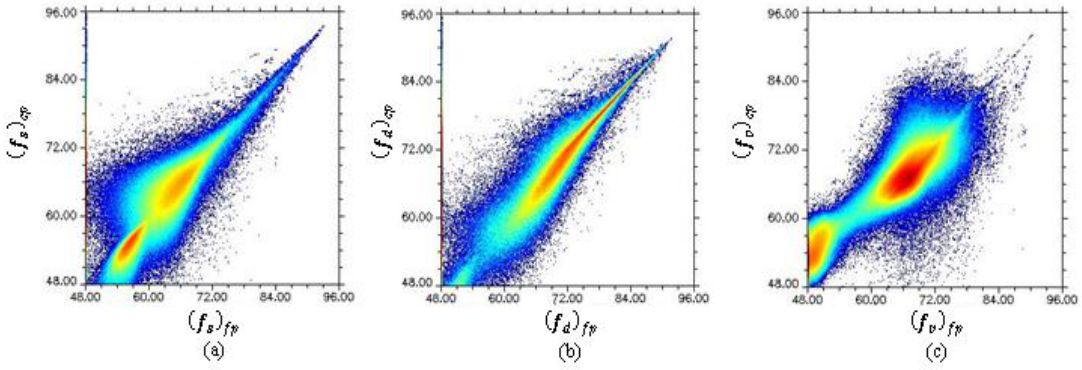
Figure 10: (a)-(c) scatter plots of the reconstruction performance for odd ( ( (cid:2188) (cid:2201) ) (cid:3033)(cid:3043) - ( (cid:2188) (cid:2201) ) (cid:3030)(cid:3043) ), double( ( (cid:2188) (cid:2186) ) (cid:3033)(cid:3043) - ( (cid:2188) (cid:2186) ) (cid:3030)(cid:3043) ) and volume scattering ( ( (cid:2188) (cid:2204) ) (cid:3033)(cid:3043) - ( (cid:2188) (cid:2204) ) (cid:3030)(cid:3043)